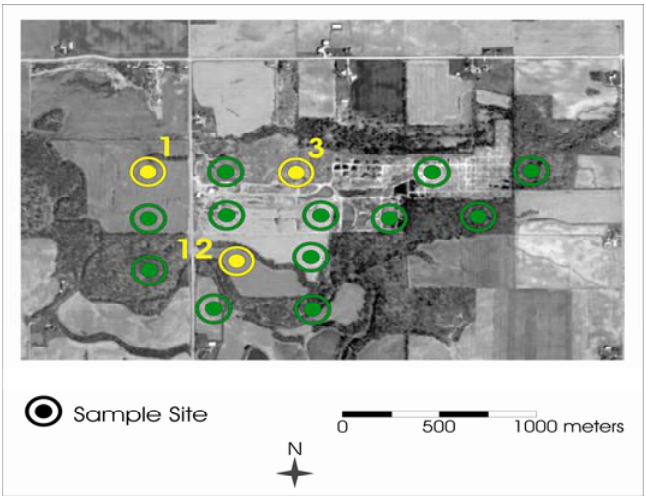
Figure 9. Location of sample points used in